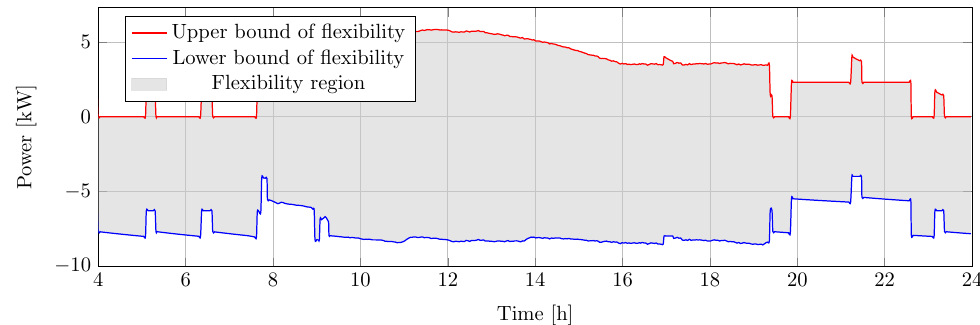
Figure 8. Available upward and downward flexibility for the winter sunny day scenario.